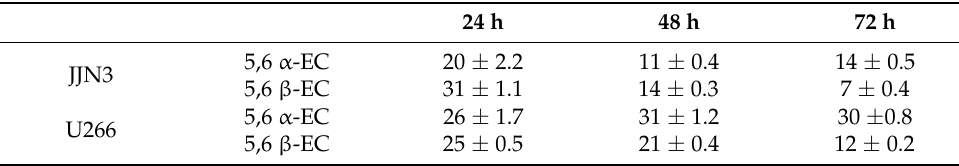
Table 1. IC 50 values of 5,6 α / β -EC for the different periods of